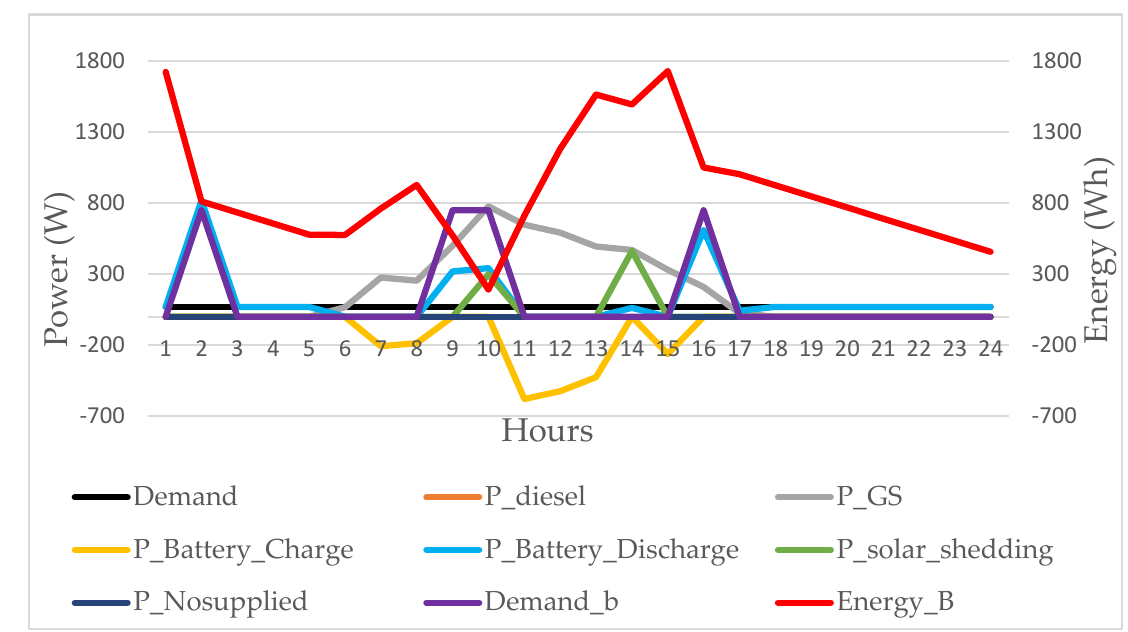
Figure 7. Energy management of a day with the proposed optimal